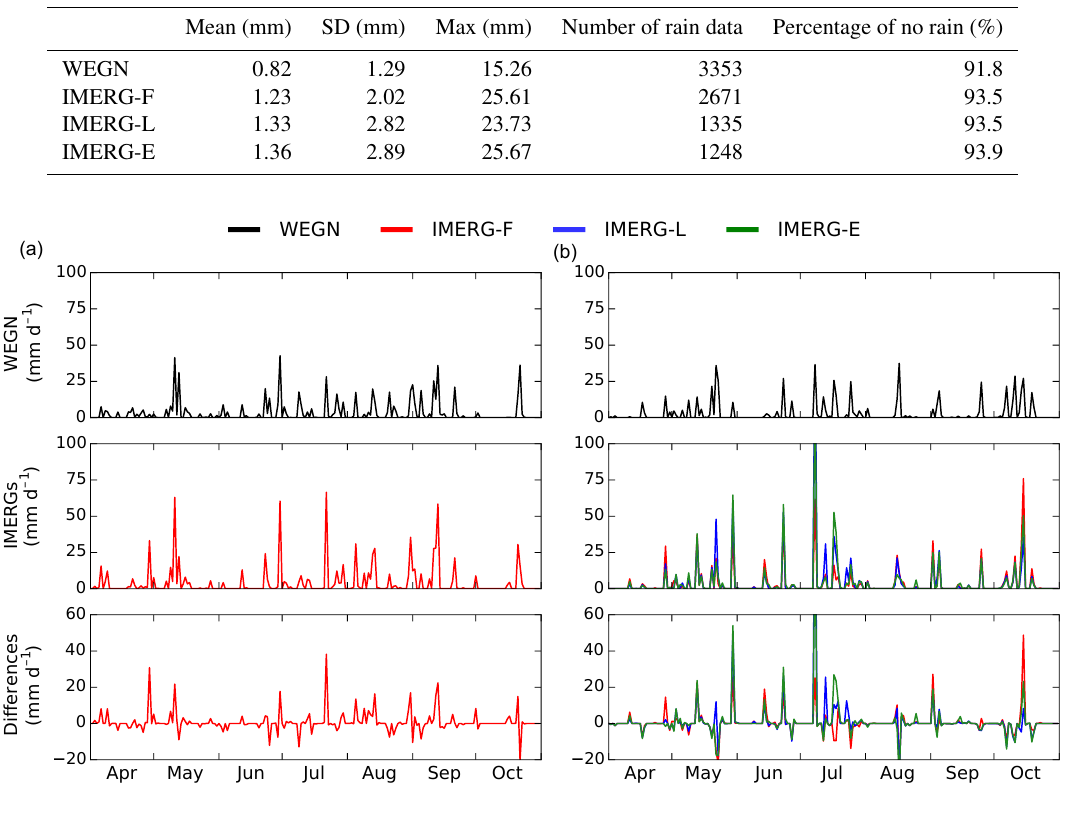
Table 1. Description of the data: mean, standard deviation (SD), maximum, number of rainfall amount values ( ≥ 0.05mm30min − 1 ), and